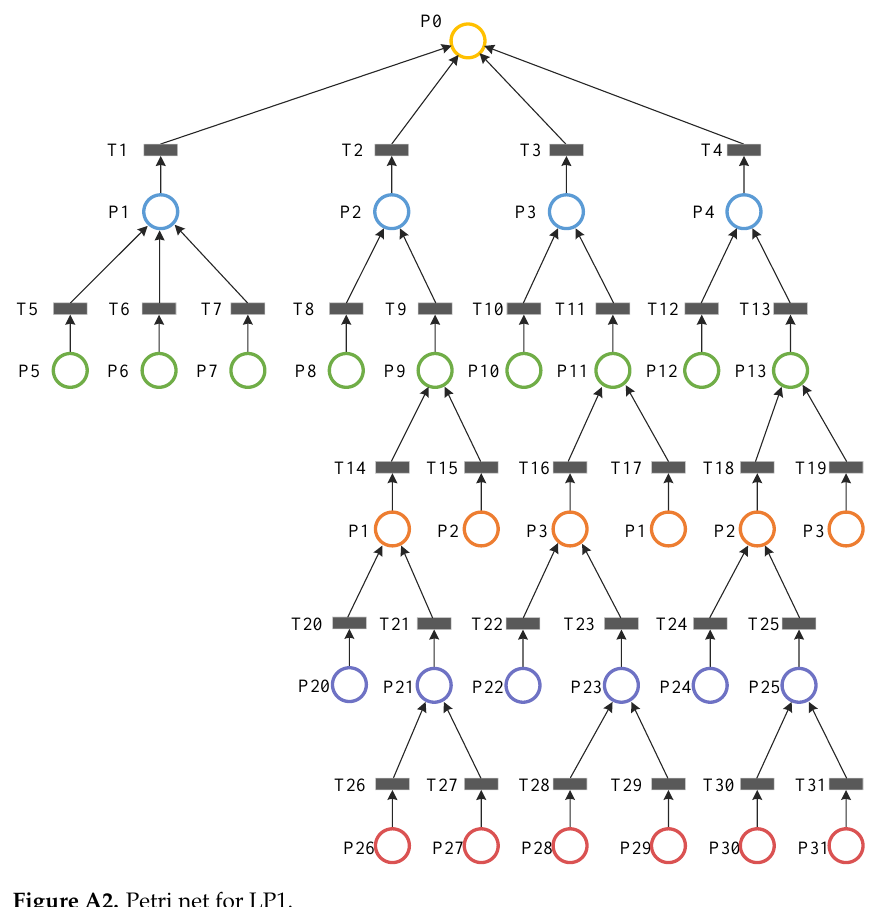
Figure A2. Petri net for LP1.